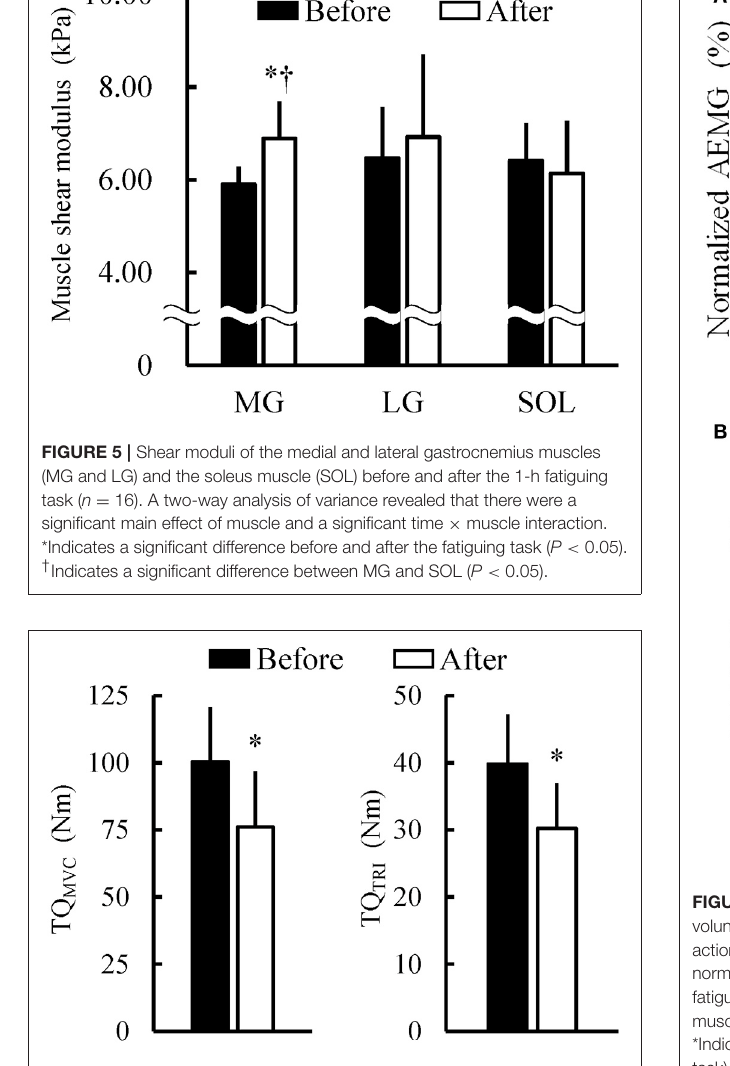
FIGURE 6 | Peak joint torque during maximal voluntary contraction of isometric plantar flexion (TQ MVC ) and evoked peak triplet torque (TQ TRI ) before and after the 1-h fatiguing task ( n = 16). *Indicates the significant difference before and after the fatiguing task ( P < 0.05).